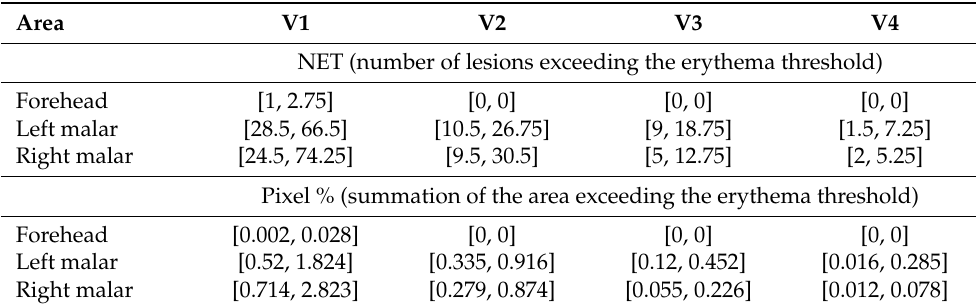
Table 3. Median and IQR (interquartile range) of NET (number of lesions exceeding the erythema threshold) and Pixel % (summation of the area exceeding the erythema threshold) of acne vulgaris patients at each visit, suggested [median,